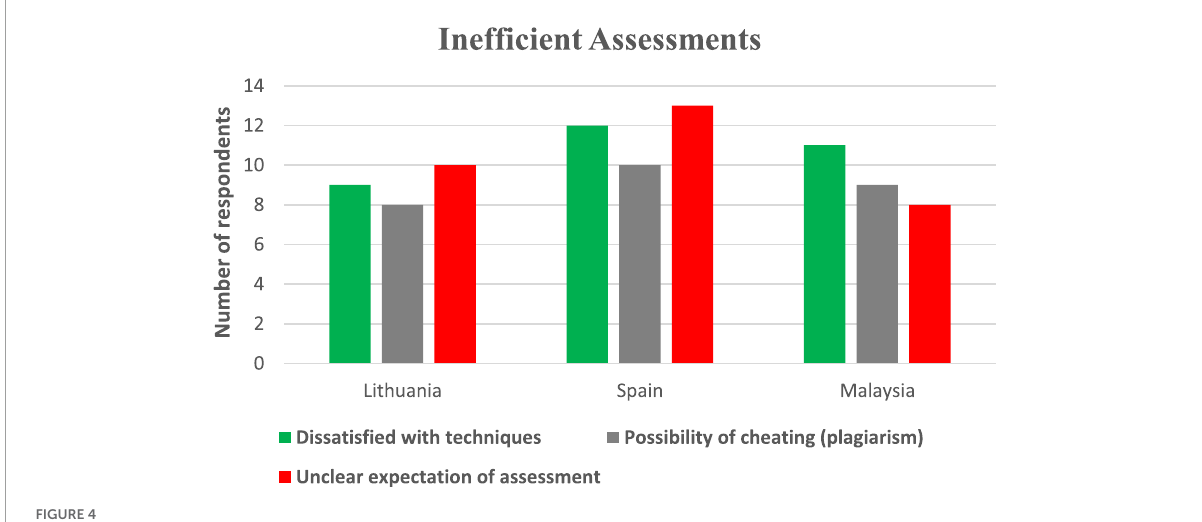
FIGURE4 Number of participants and categories for the theme related to inefficient